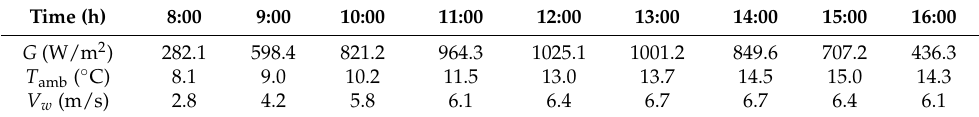
Table 2. Weather data of a typical sunny day in Baghdad city on 14 January 2021.